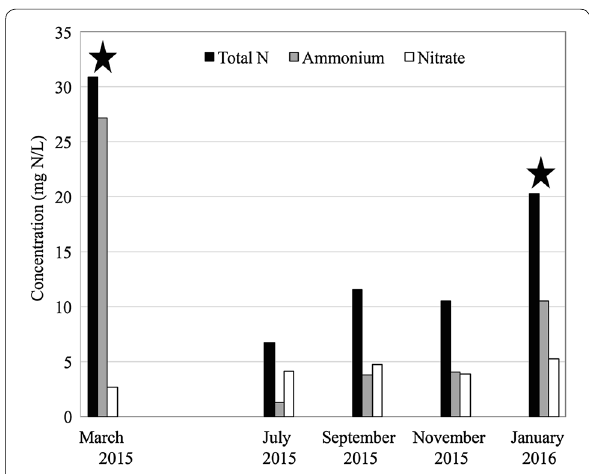
Fig. 1 Total soluble initial nitrogen, ammonia, and nitrate concentra‑ tions data from the effluent of aeration basin at Amherst wastewater treatment on the day the inoculum biomass was collected for a culti‑ vation. Stars indicate the data associated with successful cultivations